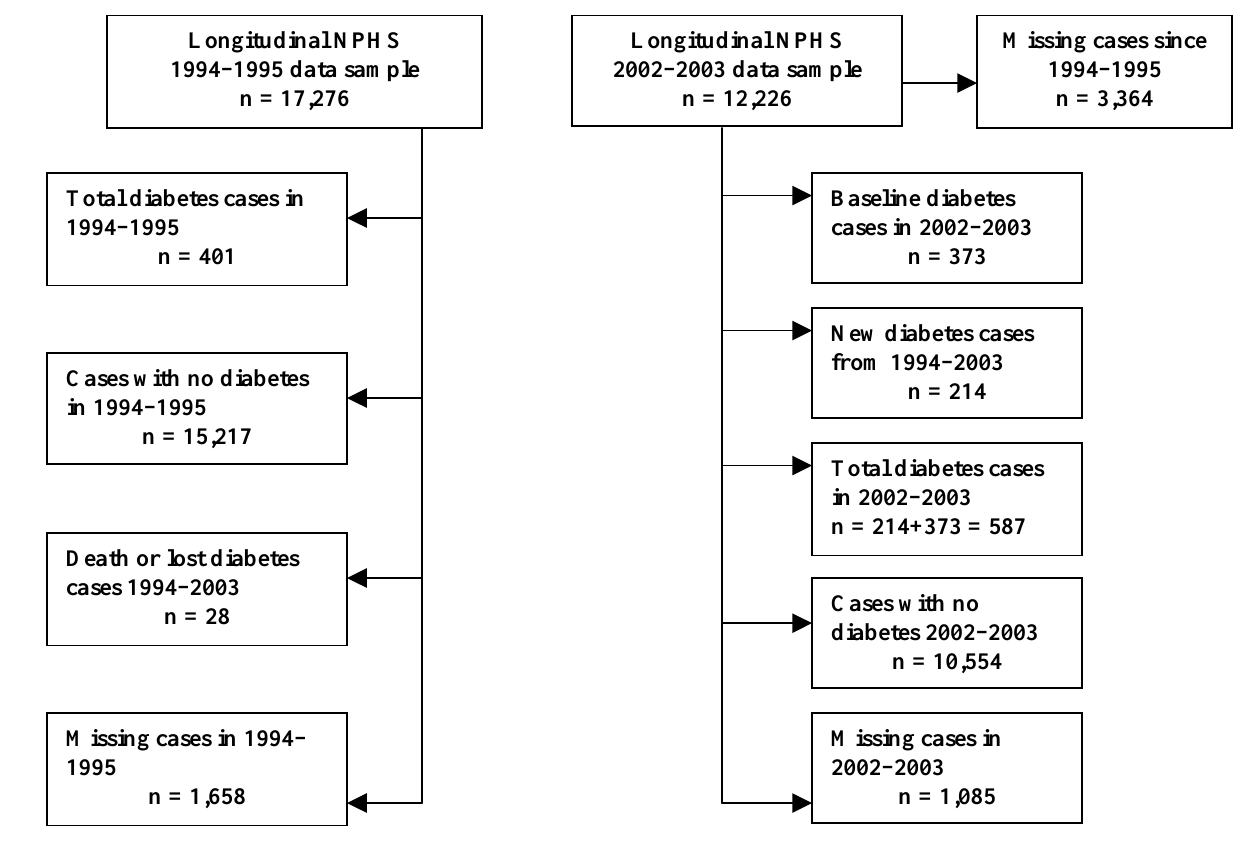
FIGURE 1. Study sample, NPHS Longitudinal Data of diabetes, from